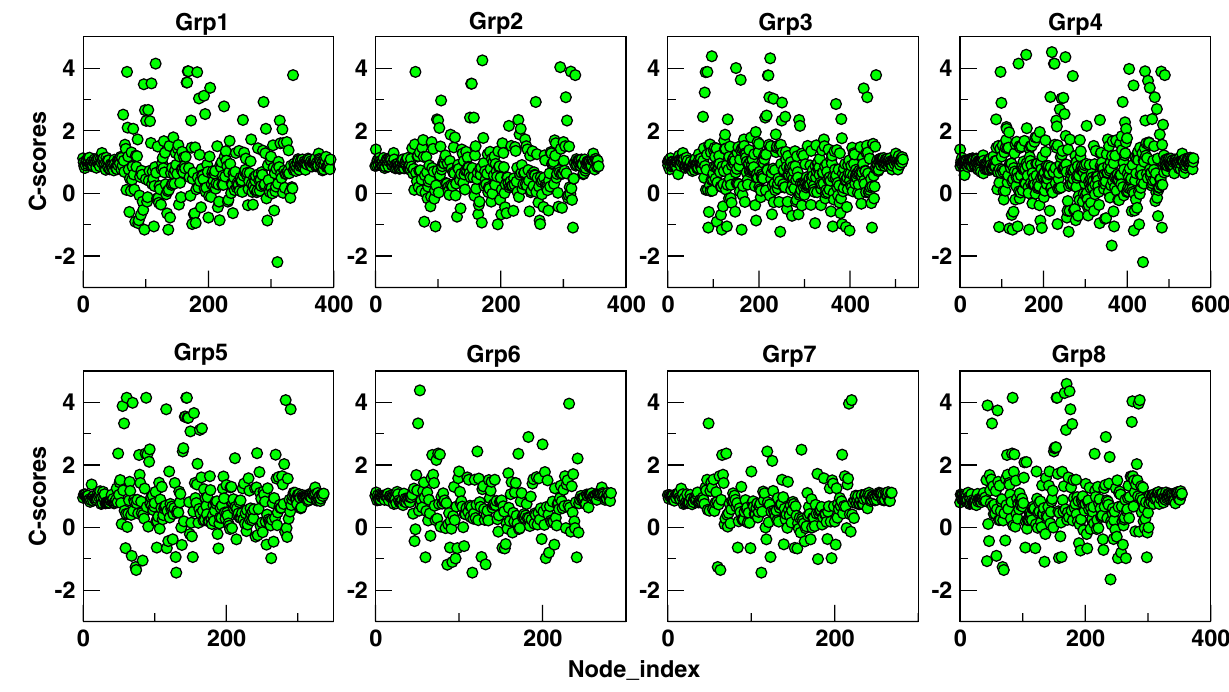
Figure 8. The CADD scores are plotted for all the nodes of each master co-occurrence network. The negative values show proxy neutral predictions while the positive values show proxy deleterious predictions for each variable